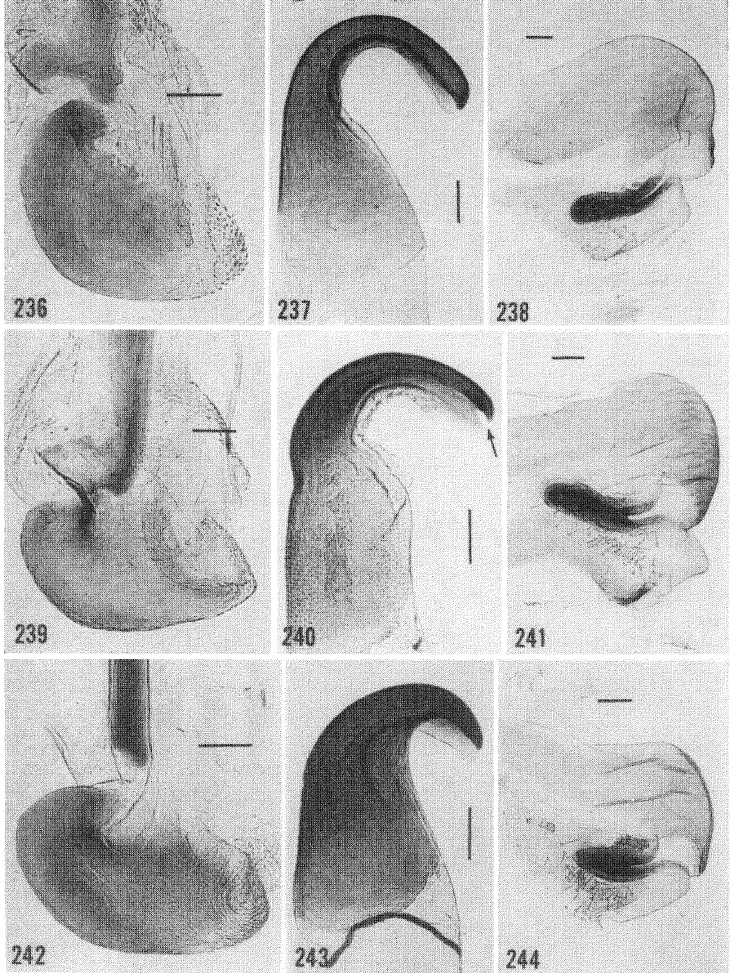
Figures 236-244. Male genital phallomeres of Perishaerus spp. 236- , 238. (176 ANSP). P. contiguus (from shown in Fig. 227). 239-241. (39 CUZM). P. flaicornis (from shown in Fig. 228). 242-244. P. semi- lunatus (from shown in Fig. 230). (scale’-- 0.1